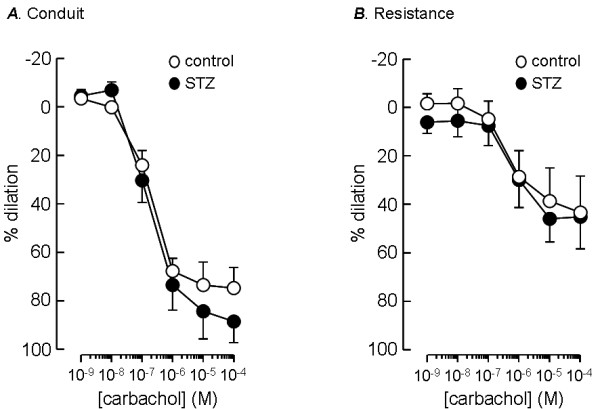
Resistance of endothelium-dependent vasodilation to STZ-induced diabetes. Dilator responses to increasing concentrations of carbachol, measured as a percentage of pre-constrictor tone, in conduit (A) and resistance-sized (B) intrapulmonary arteries from STZ-treated (solid circles) and age-matched control (open circles) rats. Data plotted are mean ± s.e.m. of 9–11 animals.